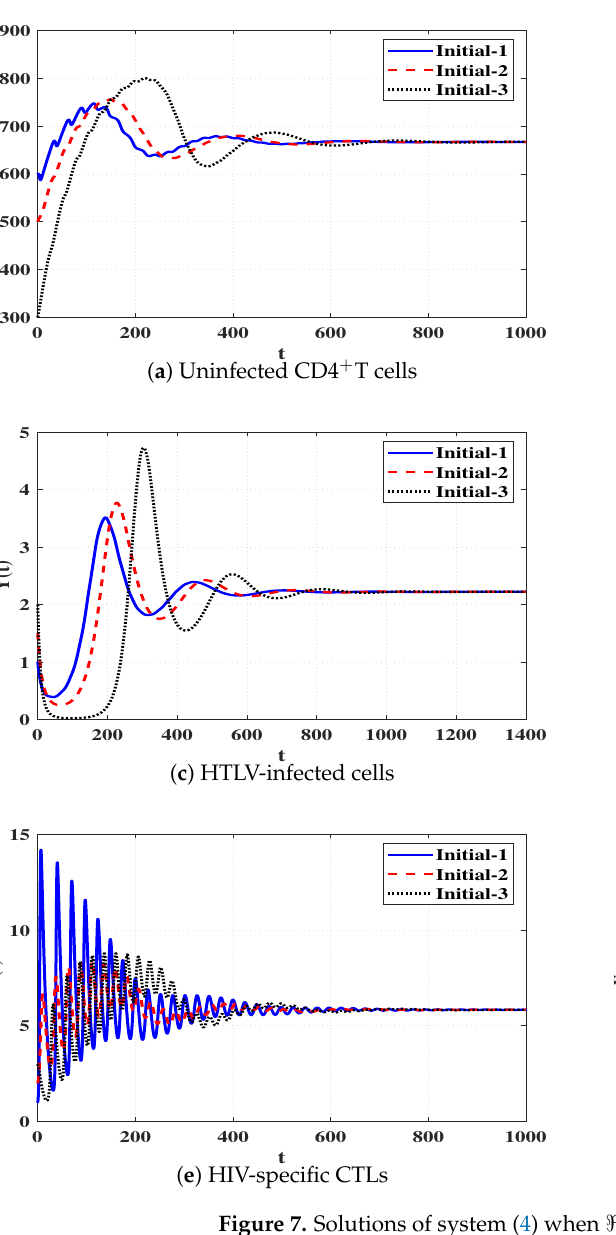
Figure 7. Solutions of system (4) when (cid:60) 5 > 1, (cid:60) 8 ≤ 1, and (cid:60) 1 / (cid:60) 2 > 1.